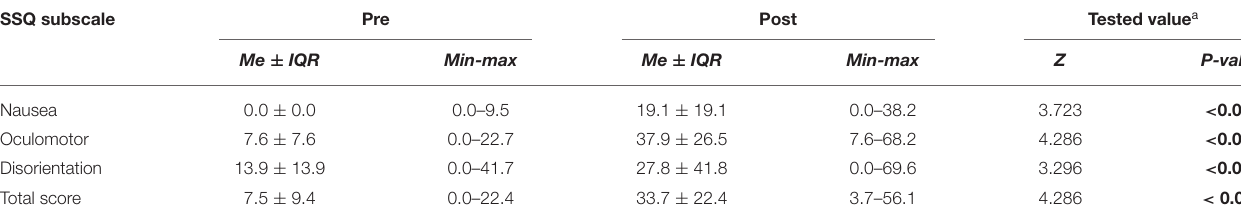
TABLE 3 | Descriptive statistics and differences in pre- and post-exposure SSQ scores. SSQ subscale